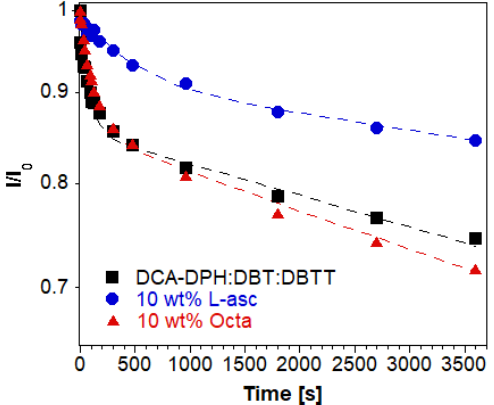
Table 1. Parameters of bi-exponential fits of the photodegradation aging tests and corresponding decay times for DCA-DPH:DBT samples with and without 5 wt.%, 10 wt.% and 20 wt.% of antioxi-